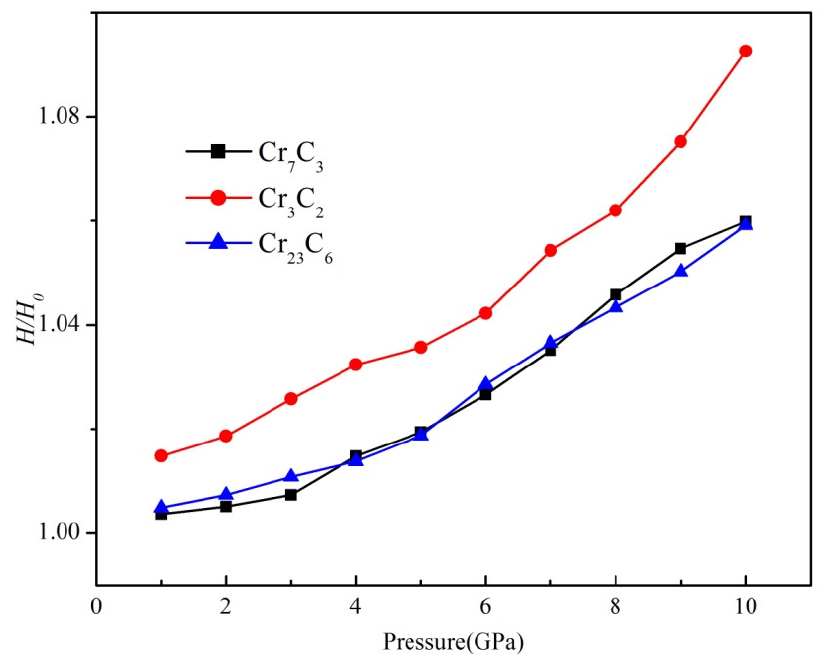
Figure 10. The relationship between H/H 0 and applied pressure.